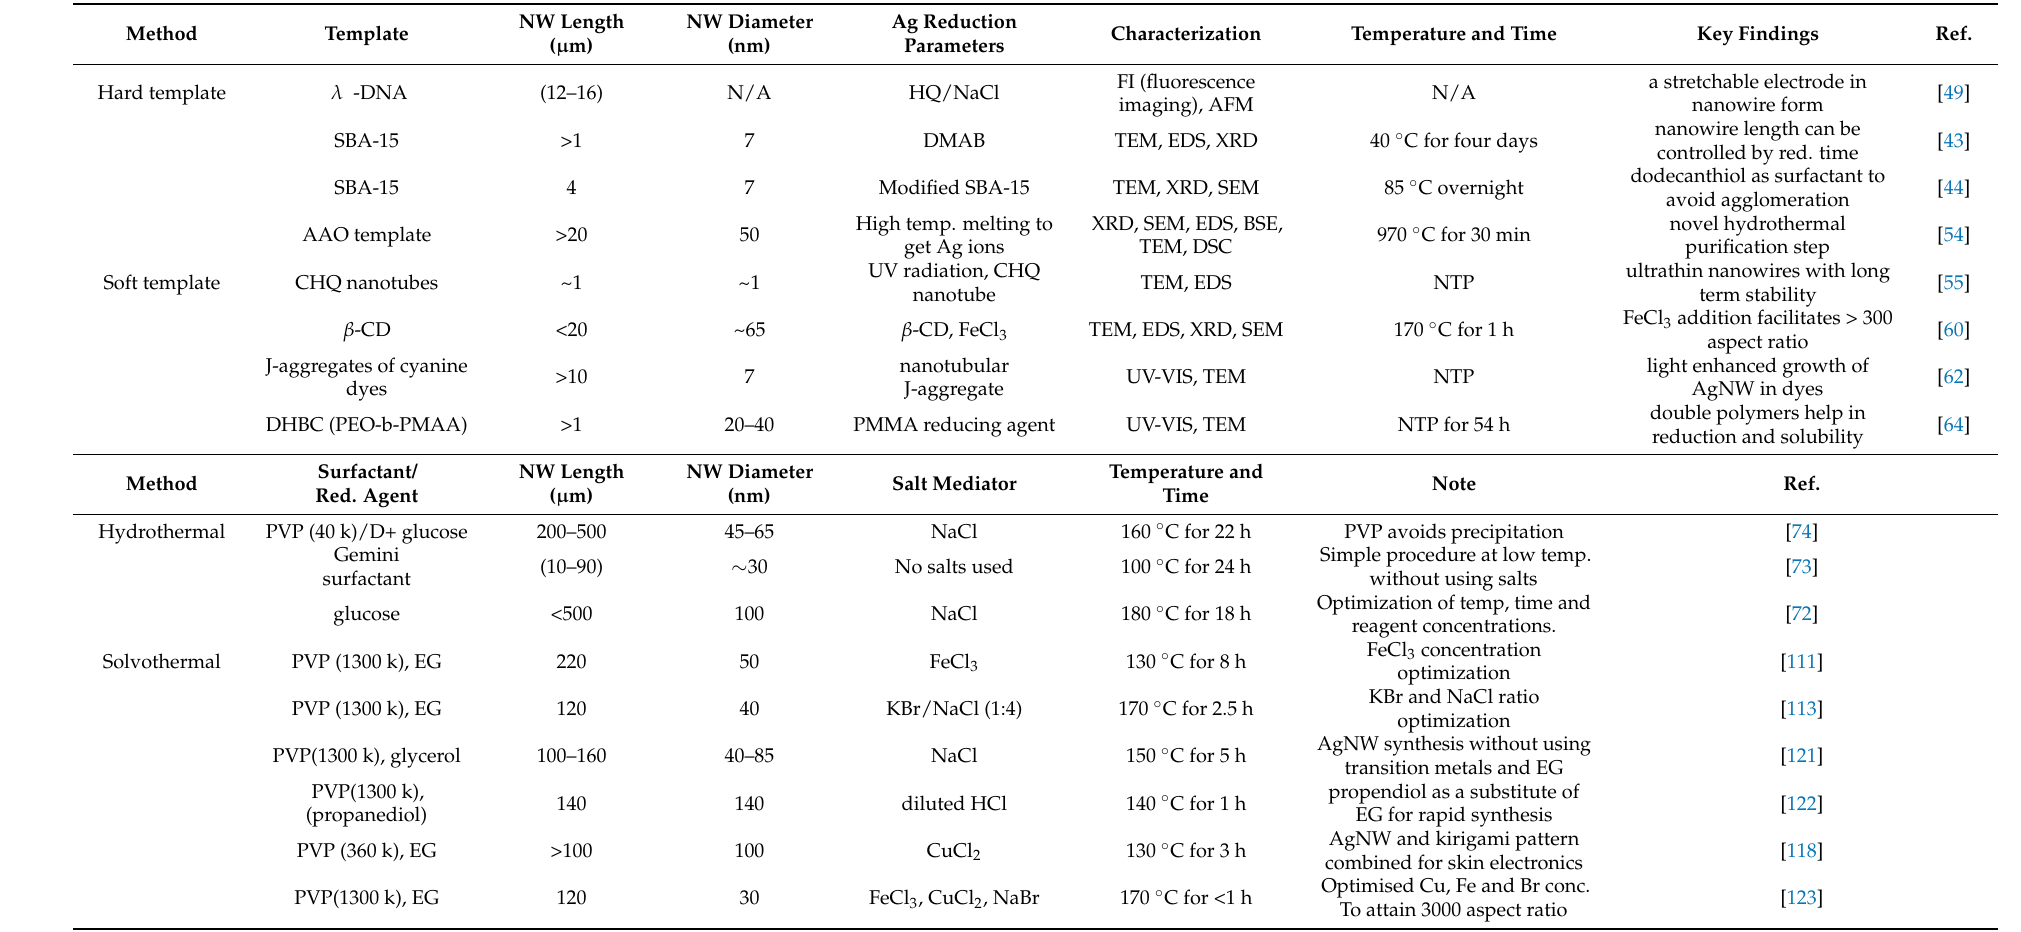
Table 1. Summarized table of AgNW synthesis